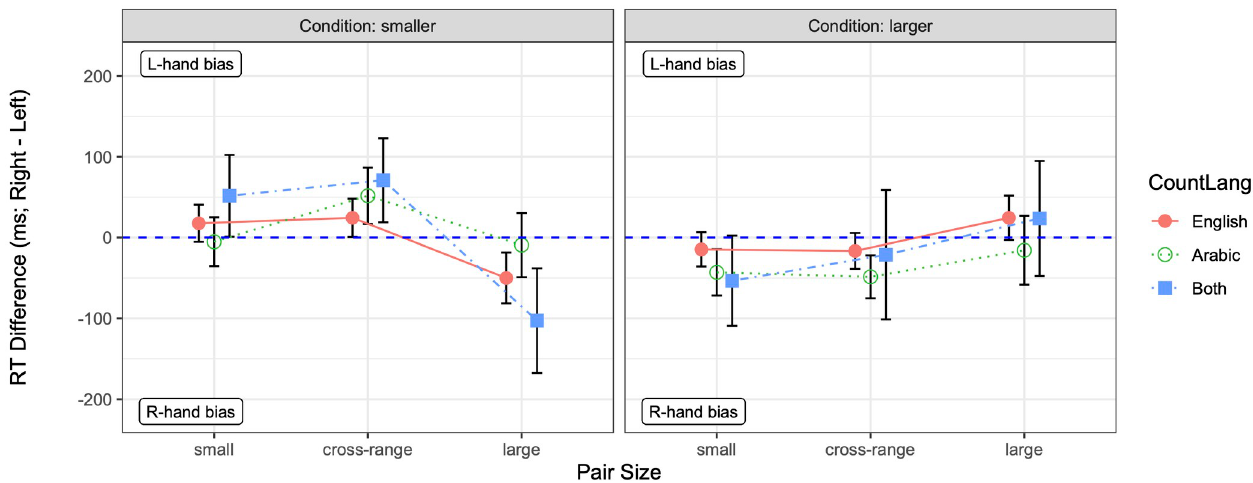
Fig 4. Mean RT differences (in milliseconds), by preferred language(s) for counting (CountLang) and pair size. The smaller condition is plotted on the left; the larger condition on the right. Each pair size represents the average over the three pairs for that pair size. The dashed horizontal line marks zero RT difference (i.e., no hand bias); error bars mark 95% confidence